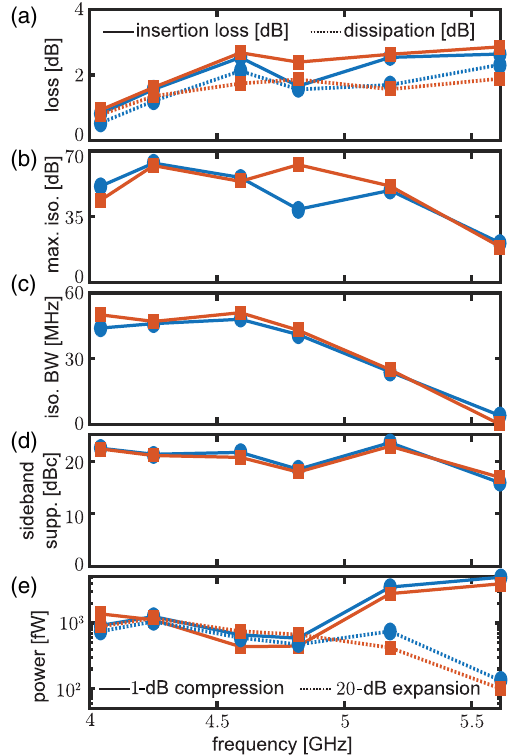
FIG. 7. Performance of a widely tunable on-chip circulator. The insertion loss [(a), solid lines], dissipation [(a), dotted lines], maximum isolation (b), isolation bandwidth (c), sideband sup- pression (d), and power handling (e) are plotted at operation frequencies between 4 and 6 GHz when the device is configured as a clockwise (orange rectangles) or counterclockwise (blue circles) circulator. Isolation bandwidth refers to the bandwidth over which isolation exceeds 20 dB. Sideband suppression refers to the contrast between transmitted spectral components at the input frequency ω and the largest spurious sideband of the form p ω (cid:2) n Ω . In (e), dotted lines indicate the device ’ s 1-dB com- p pression point and solid lines indicate the 20-dB expansion point, where isolation drops below 20